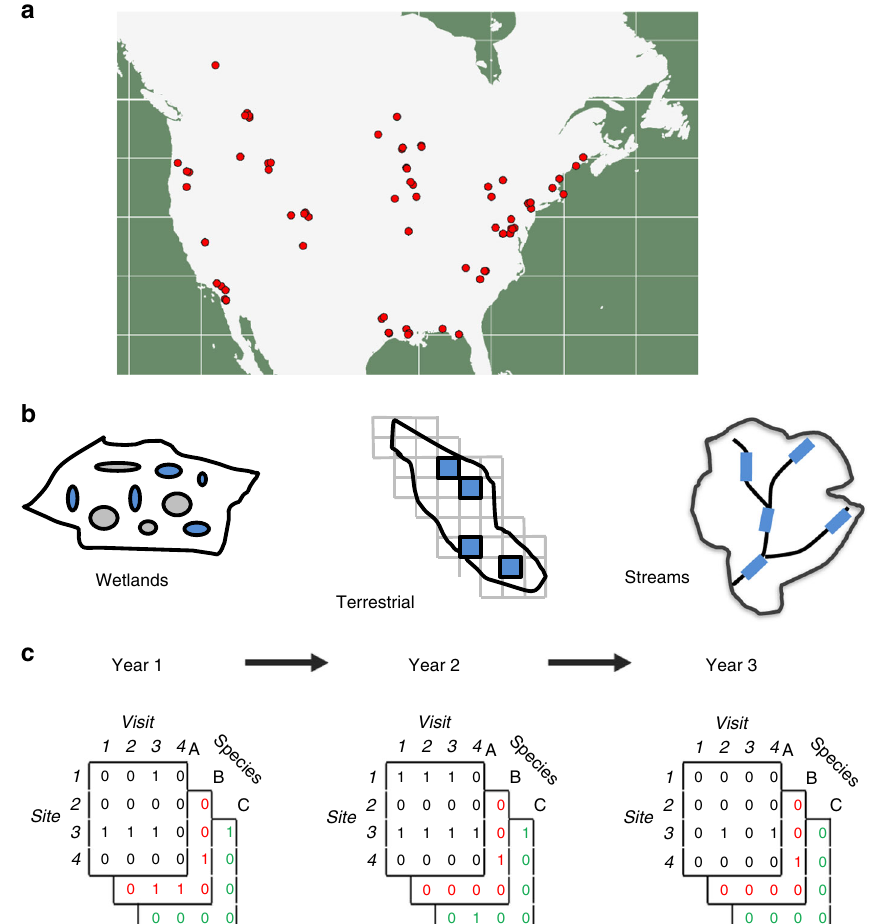
Fig. 1 Hierarchical study design. All data used in our study followed a common design. Study areas were located across the United States and Canada ( a ). Individual sites were sampled within each study area, where a site was de fi ned as a waterbody, terrestrial plot, or reach of a stream ( b ). Sites were visited multiple times each year and for multiple years. During each visit one or more species were recorded as detected or not ( c ). Overall we sampled from 86 unique study areas and data included observations for 81 different amphibian species. Maps used in this fi gure were generated using R package